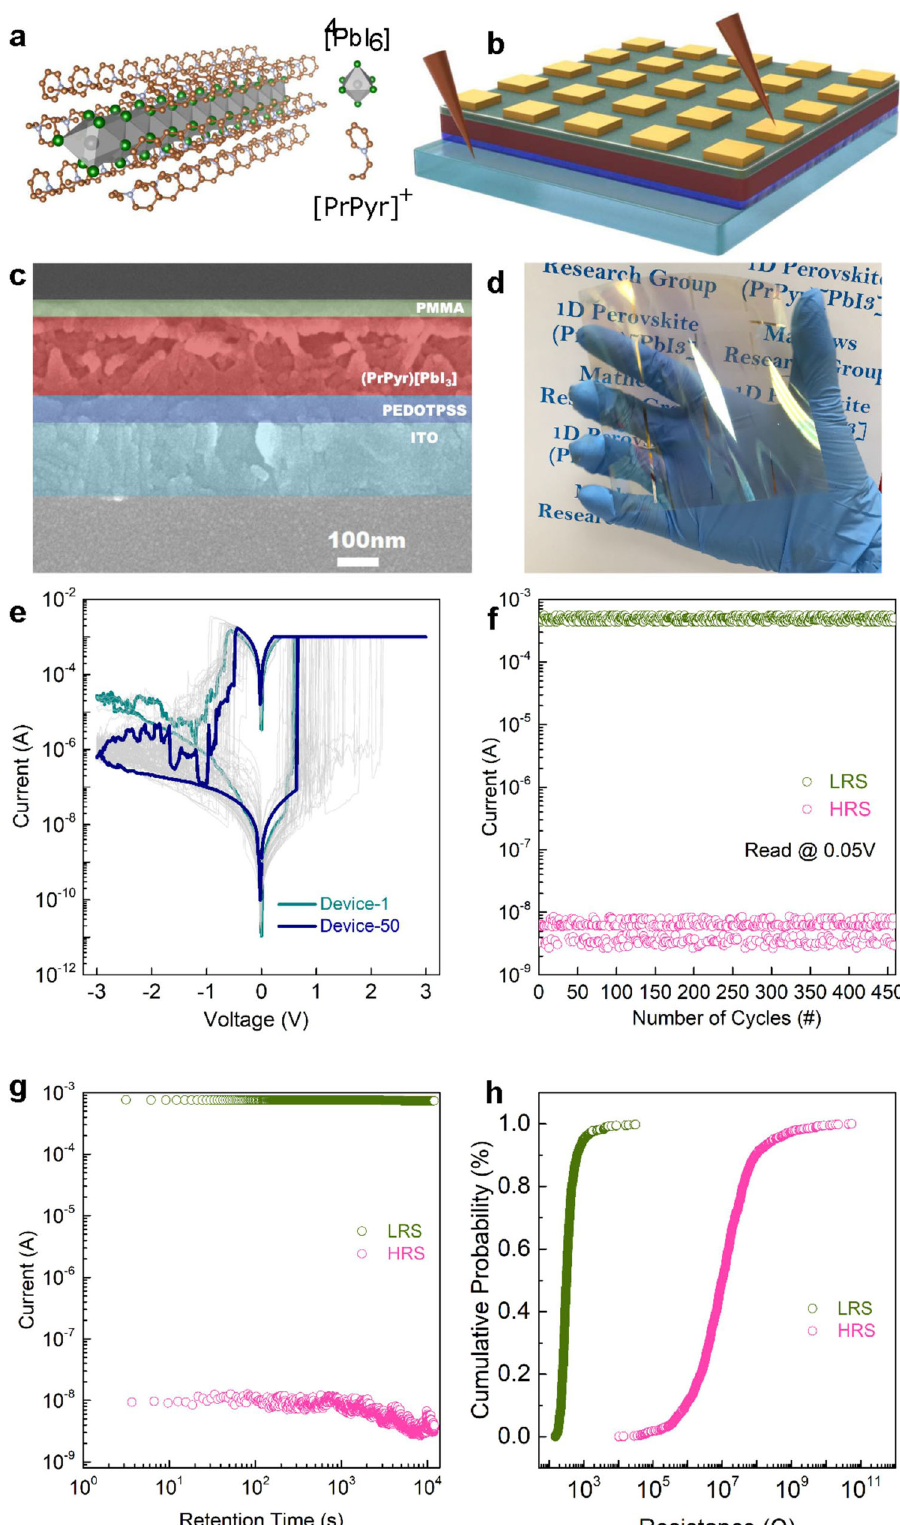
process (Fig. 2f). The cycle-to-cycle variations are exploited for recon fi guration, as discussed later. The devices maintain a high on- off ratio of >10 5 over 450 switching cycles and exhibit a retention time of ~10 4 s (Fig. 2g), reiterating the stability of the switching process. All these features represent a signi fi cant advance over previous reports of halide perovskite memristors where